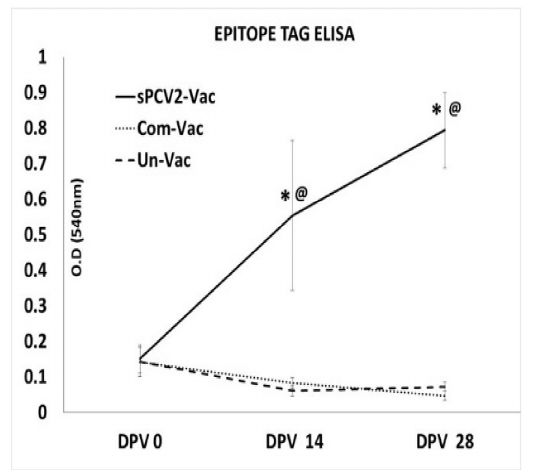
Figure 5. Antibody responses to the SRS2 epitope tag. Mean optical density values of sera obtained by an SRS2 epitope tag-specific ELISA. X -axis—time points at which serum was collected, DPV—days post-vaccination. Error bars represent the standard deviation, Y -axis—optical density (OD) values, dots—commercial vaccine, solid black—sPCV2-Vac, dashes—unvaccinated pigs. * Significantly different from the unvaccinated control group by the Student’s t -test at p ≤ 0.05, @ Significantly different from the commercial vaccine control group by the Student’s t -test at p ≤